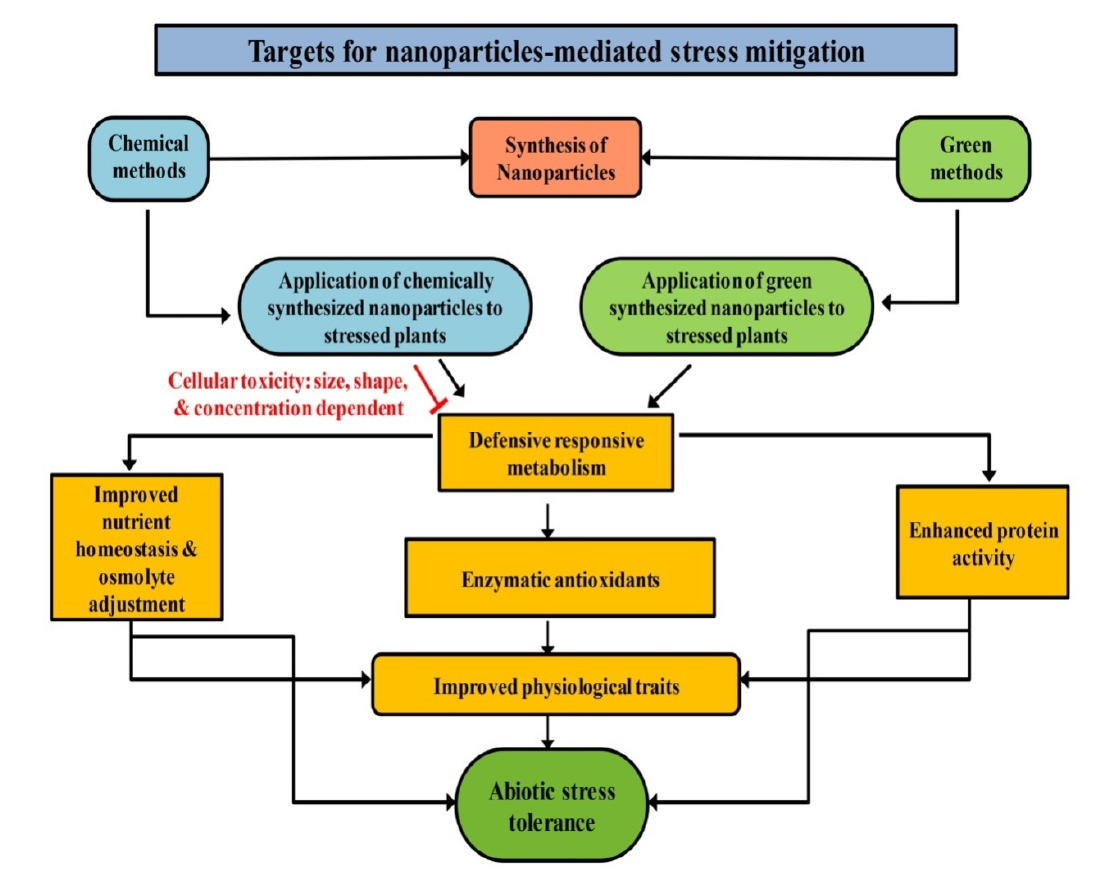
Figure 4. Potential targets for nanoparticles-mediated abiotic stress mitigation. The synthesis of nanoparticles (NPs) by green approaches is an environment-friendly method and can be efficiently used to trigger various abiotic stress-induced responses upon exogenous application to stressed plants. Chemically synthesized NPs show nanotoxicity and limit the ameliorative responses for abiotic stress alleviation (indicated by the red inhibitory arrow). Strategies focused on eliciting plant defense responses by triggering osmotic adjustment, antioxidant machinery for amelioration of cellular damage by ROS, and improving protein activity, can be efficient in conferring resistance to various abiotic stresses. Green synthesized NPs prove to be a suitable candidate for stress mitigation as they help in altering the gene expression of enzymatic antioxidants (SOD, CAT, and GR), and enhance osmotic content and nutrient homeostasis. Furthermore, green synthesized NPs favor the enhancement in protein activity, particularly of enzymes involved in N and proline metabolism which help in accomplishing the abiotic stress tolerance in crops. CAT, catalase; GR, glutathione reductase; N, nitrogen; ROS, reactive oxygen species; SOD, superoxide dismutase.